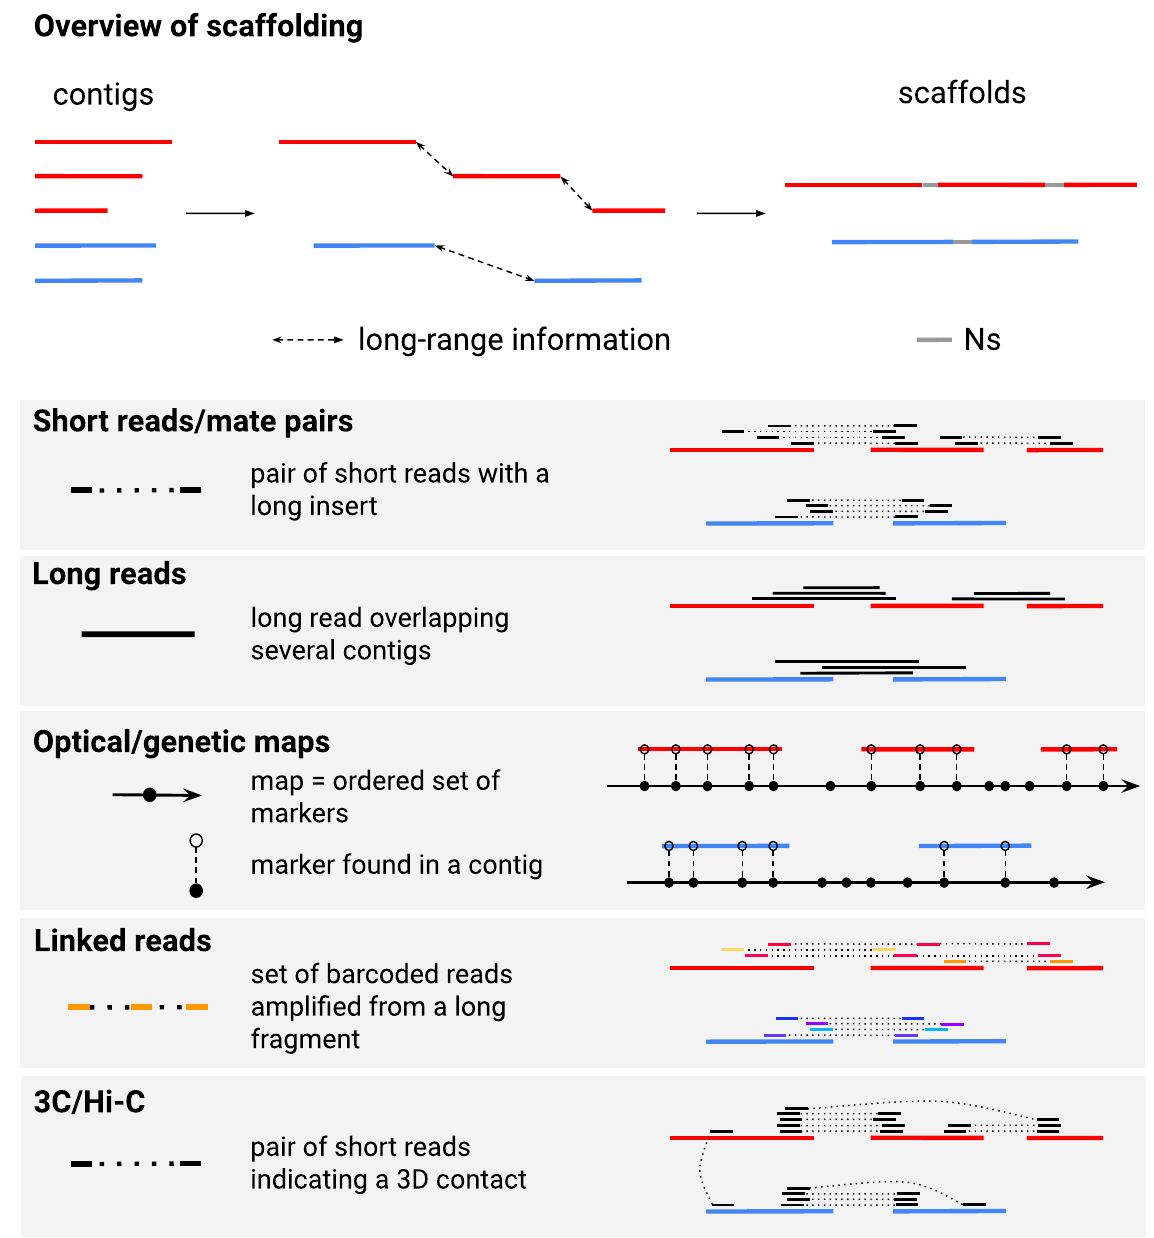
Figure 7 – Overview of scaffolding